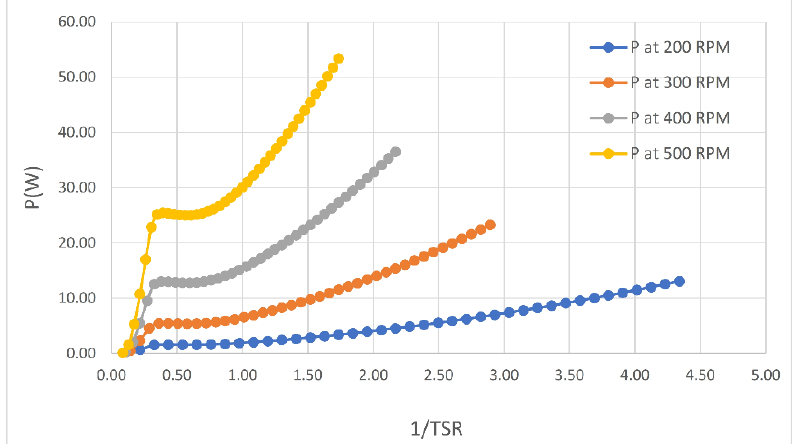
Figure 7. Power ( W ) vs. 1/tip speed ratio (TSR) for 3 blades of VAWT with different speed using